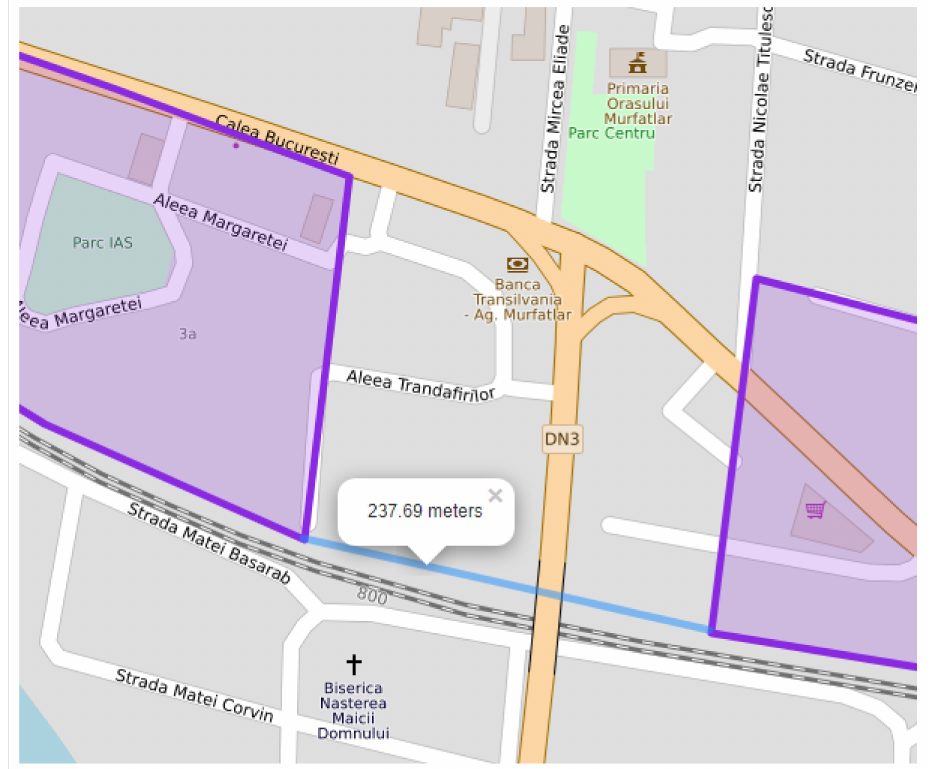
Figure 19. Distance measurement between any map points. In this case between two validated archeological sites (purple).